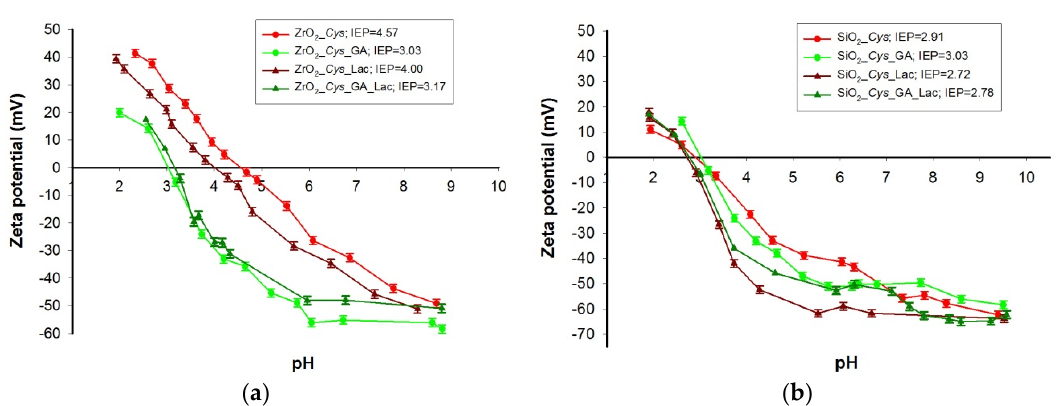
Figure 3. Zeta potential values as a function of pH for samples based on ( a ) ZrO 2 and ( b ) SiO 2 before and after immobilization.